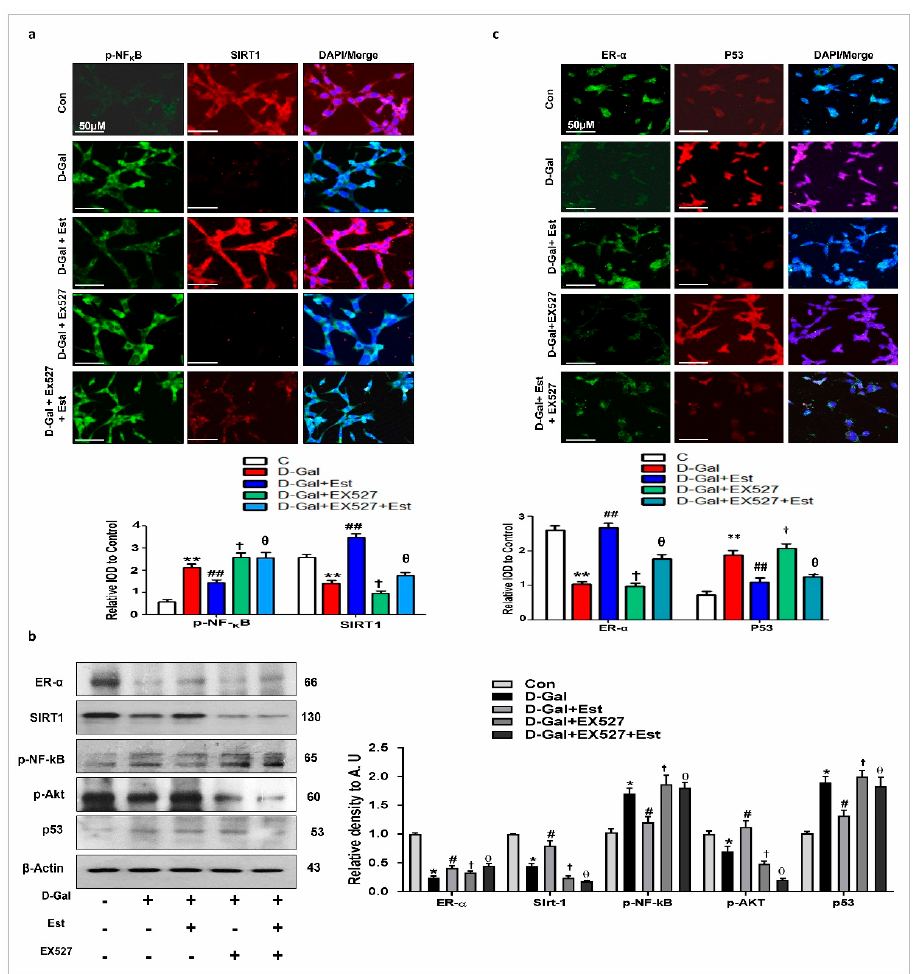
Figure 5. 17 β -estradiol in SIRT1 dependent manner abrogates d -gal-induced neuroinflammation and neurodegeneration in vitro. ( a ) The double immunofluorescence images of SIRT1 and p-NF-kB